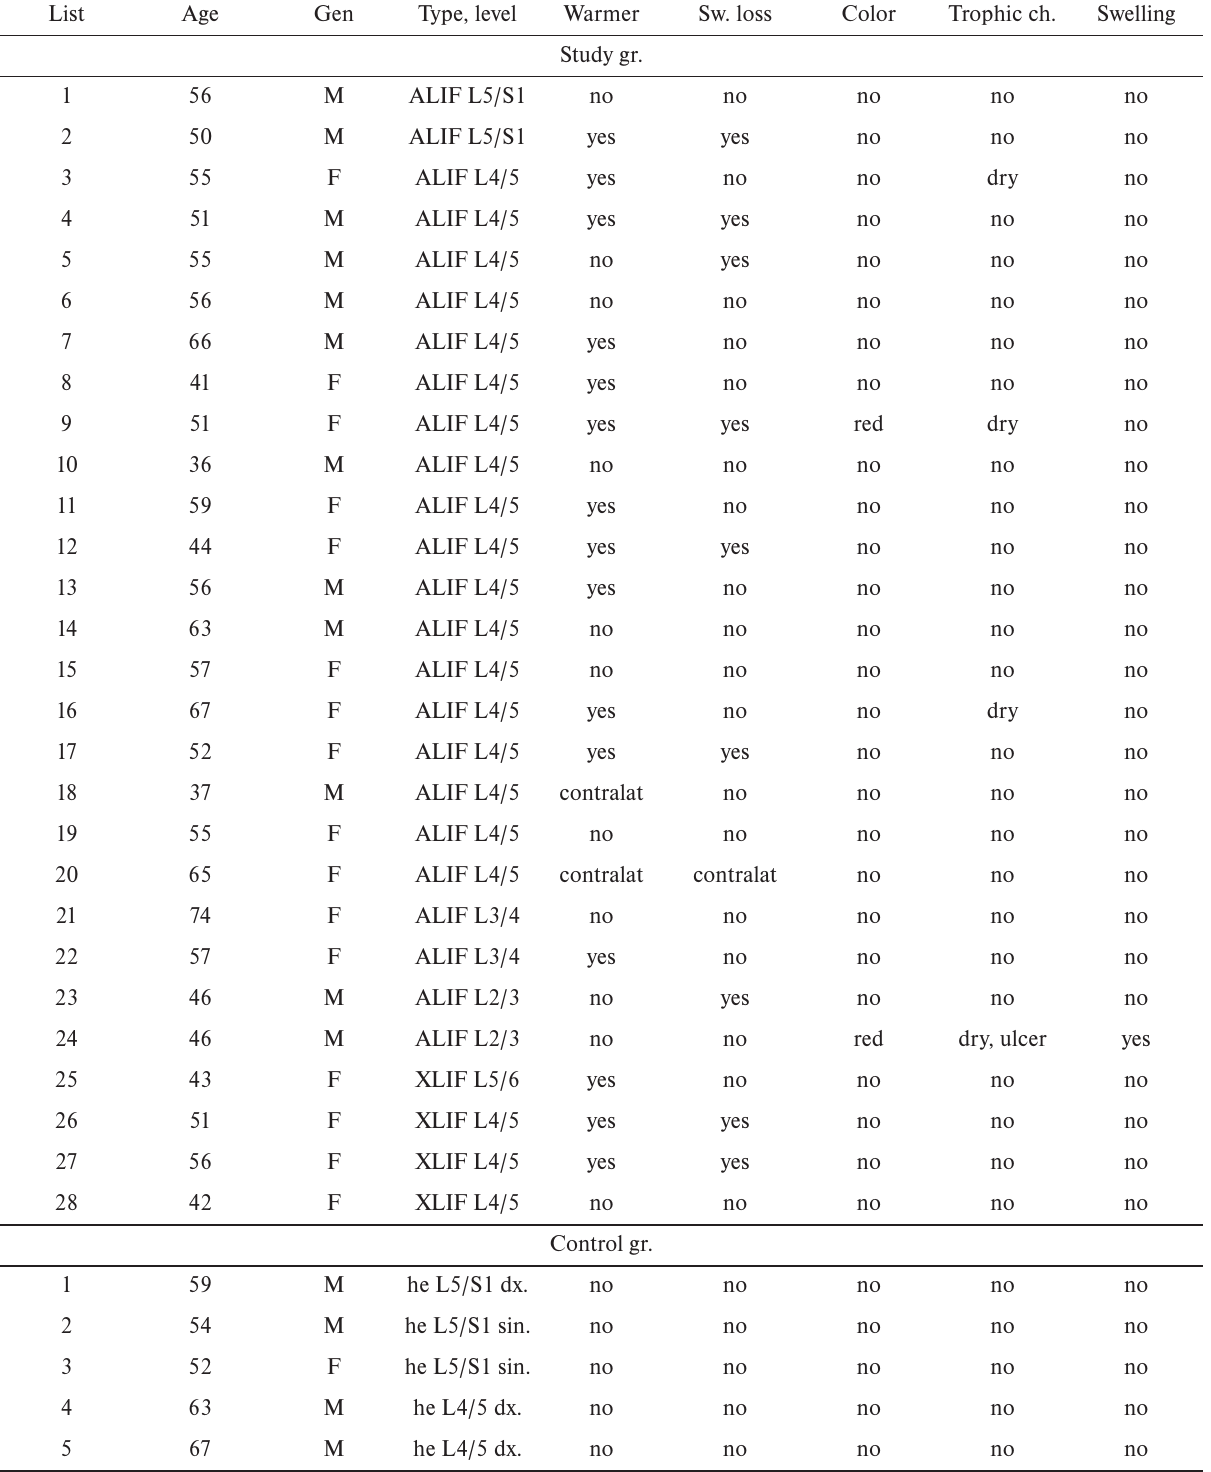
Table 2. List of patients; symptoms and signs of